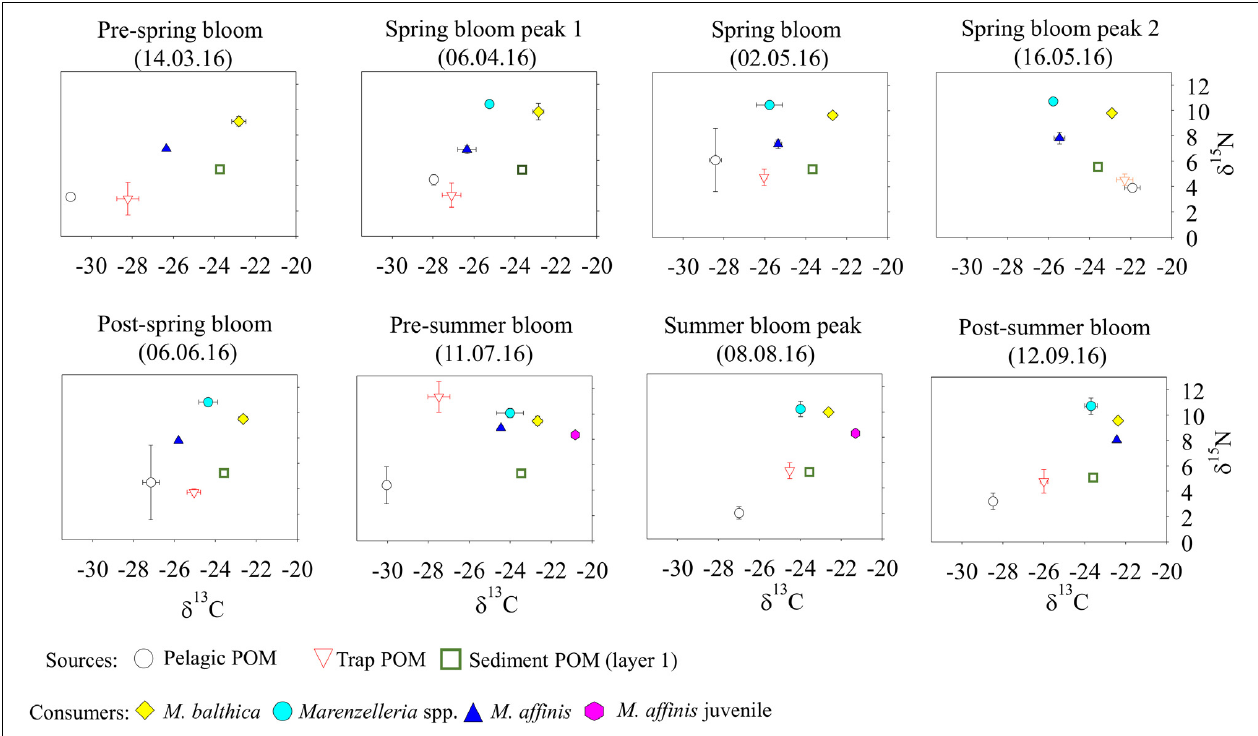
FIGURE 7 | Isotopic distribution of the organic sources collected from the different compartments (POM from the water column, POM from the sediment traps, and seafloor POM from surface layer 1) and the main benthic consumers ( Macoma balthica , Marenzelleria spp., and Monoporeia affinis in both adult and juvenile stages) over selected sampling dates encompassing specific periods of pre-bloom, peak-bloom, and post-bloom. Mean values ± SD are